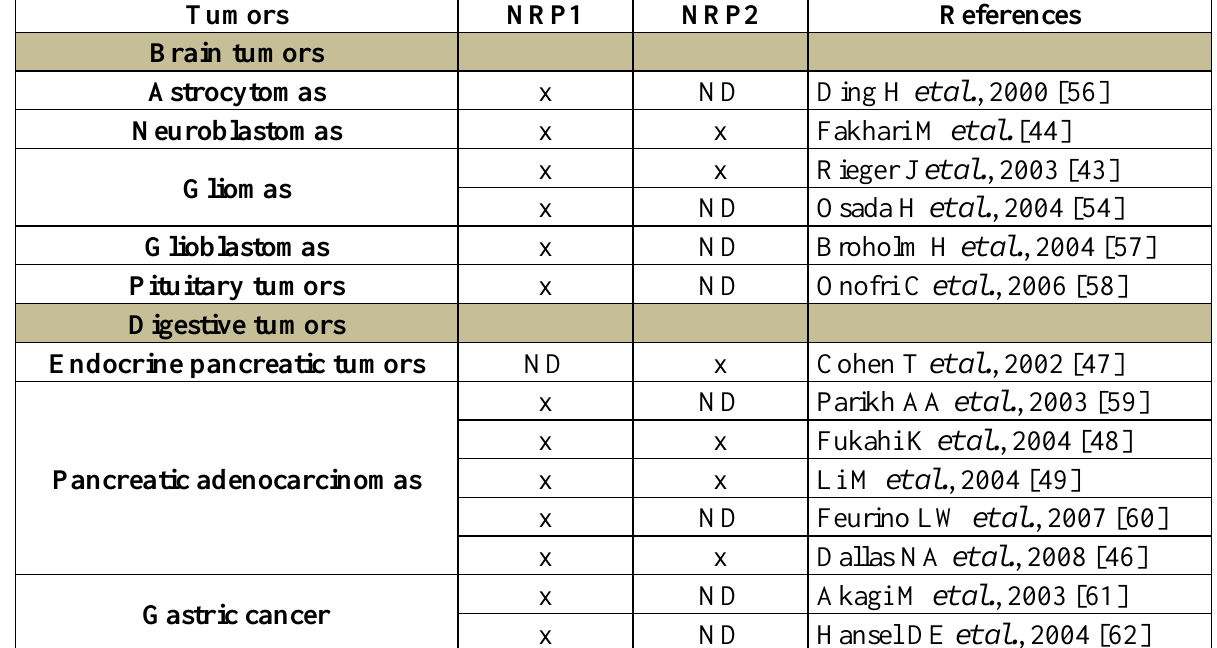
Table 1. Neuropilins (NRPs) expression in cancer